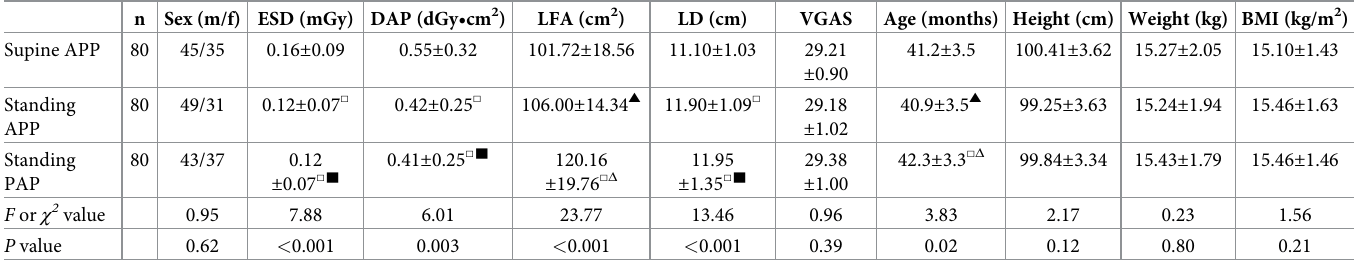
Note: □ indicates a statistically significant difference compared with the supine APP group ( P < 0.05); Δ indicates a statistically significant difference compared with the standing APP group ( P < 0.05); ▲ indicates no statistically significant difference compared with the supine APP group ( P > 0.05); and & indicates no statistically significant difference compared with the standing APP group ( P > 0.05).